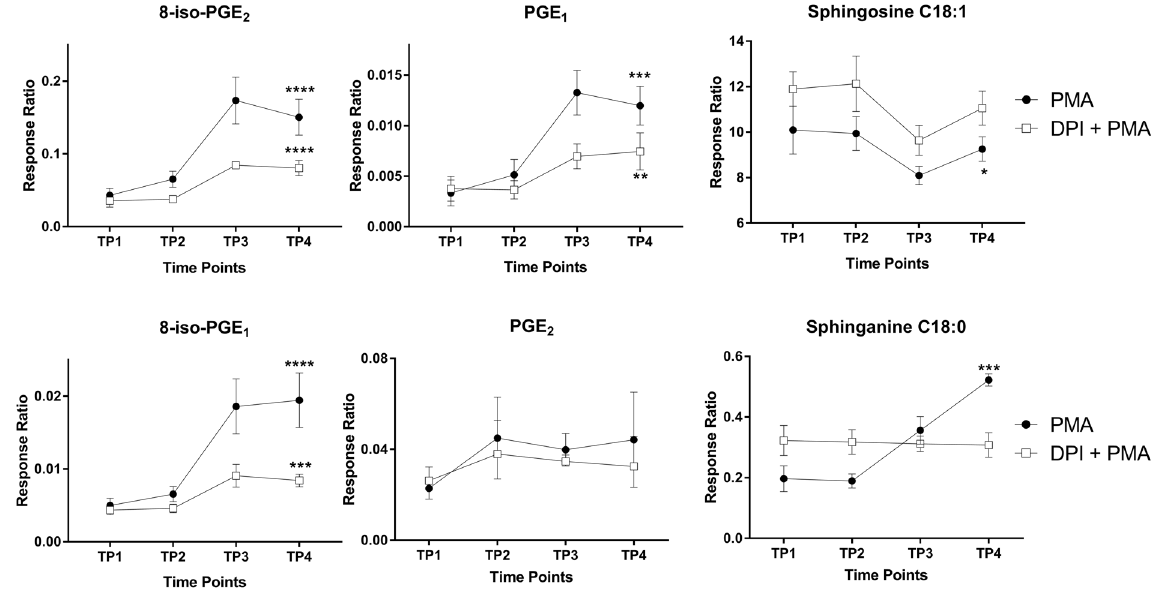
** p < 0.01, *** p < 0.001, and **** p <